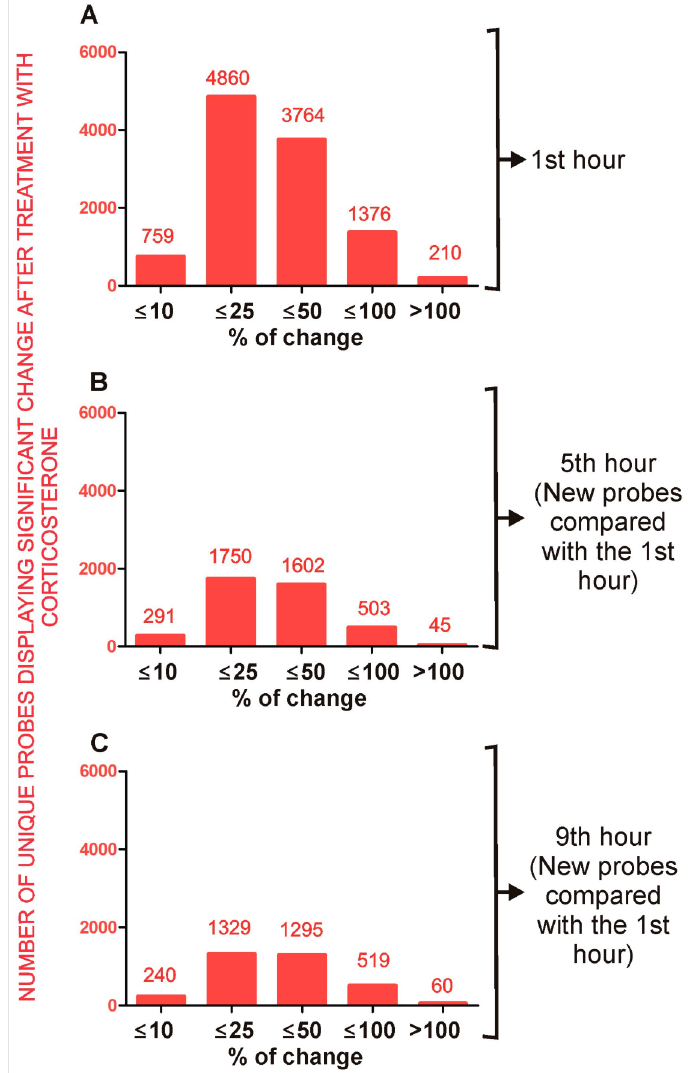
Figure 9. General characteristics of secondary effects of corticosterone characterized by significant differences occurring only during the fifth and/or the ninth hour of the resting period ( B , C ) in comparison with primary effects shown in panel ( A ). ( A )—number of unique probes that indicated significant differences during the first hour of the resting period representing primary effects. ( B )— number of unique probes that indicated the lack of effect of corticosterone during the first hour and significant differences during the fifth hour of the resting period. ( C )—number of unique probes that indicated the lack of effect of corticosterone during the first hour and significant differences during the ninth hour of the resting period. Numbers above the bars indicate an exact number of unique probes showing significant differences between groups separately for categories based on the magnitude of altered expression. All data are available in File